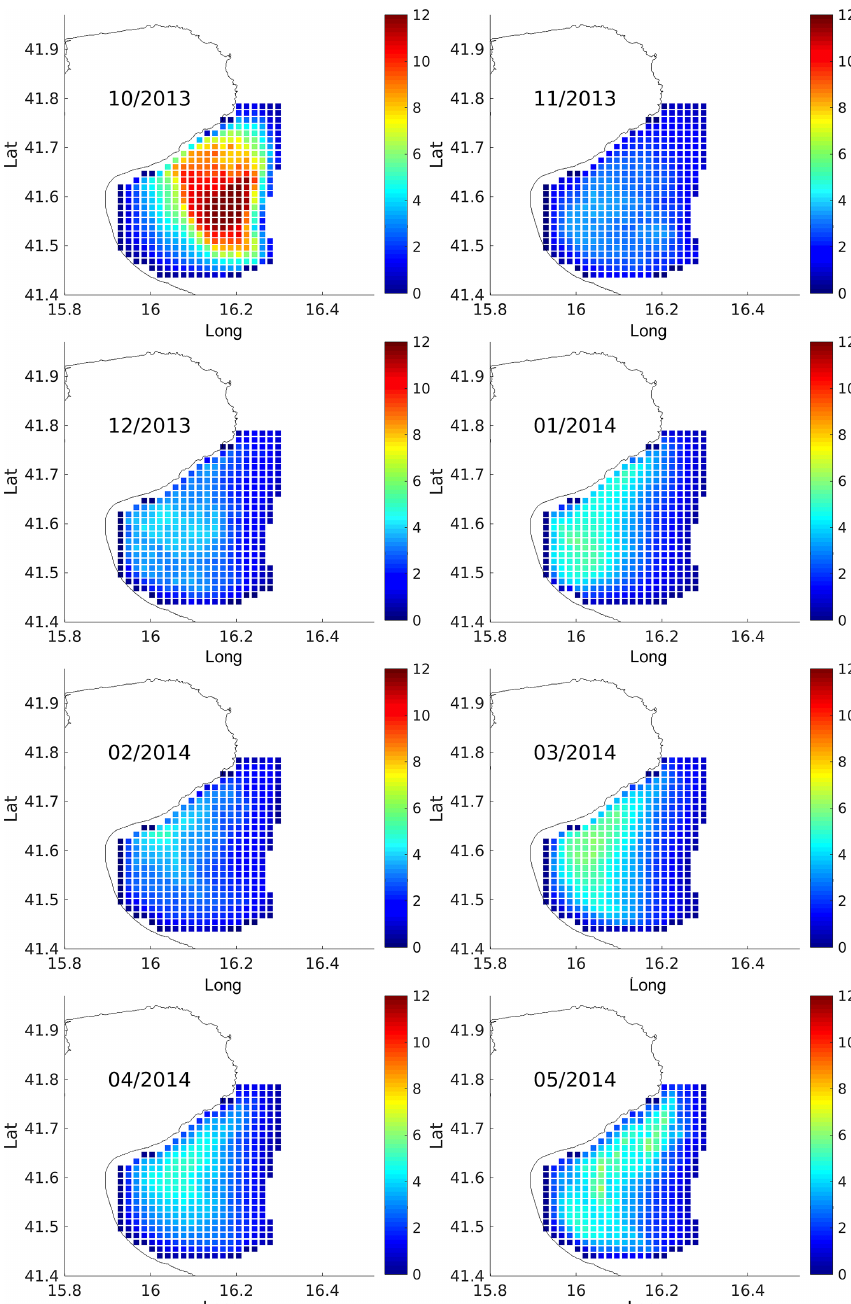
Figure 10. As for Fig. 8 but for residence time SDs (in